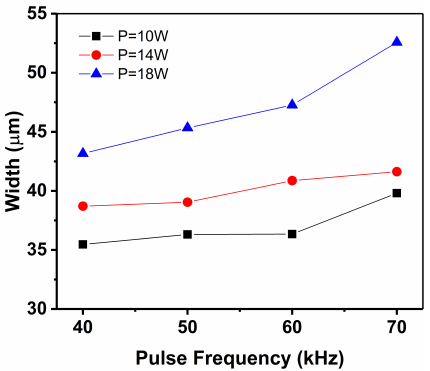
Figure 7. Effect of laser power and pulse frequency on W. Table 6. ANOVA results of W.